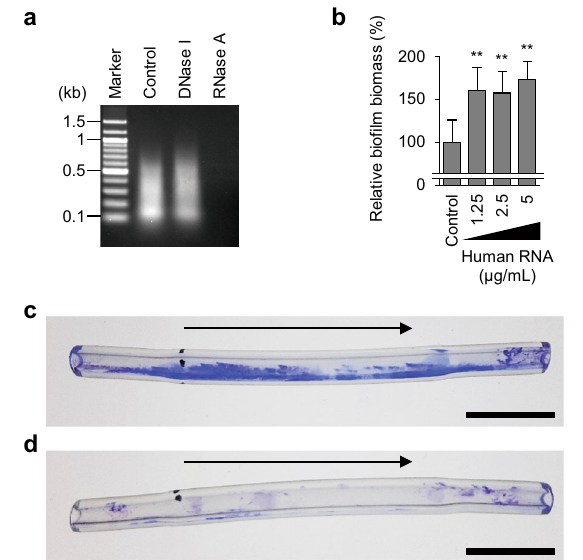
Fig. 4 Effects of human RNA on bio fi lm formation. a A pro fi le of human RNA isolated from total blood using ISOGEN-LS is shown. The puri fi ed RNA was treated with the indicated enzymes or left untreated (Control) and subsequently analyzed using agarose gel electrophoresis. b The effects of human RNA on bio fi lm formation by MR10 in RPMIG. Bio fi lm biomass is shown as mean and standard deviation (error bar) from three independent experiments. ** P < 0.01. c, d Bio fi lm formation in polyurethane tubes was analyzed under continuous fl ow conditions. MR10 was grown in PNG supplemented with ( c ) or without human RNA ( d ). Representative images of three independent experiments are shown. The arrows indicate the directions of fl ow. Scales indicate 1